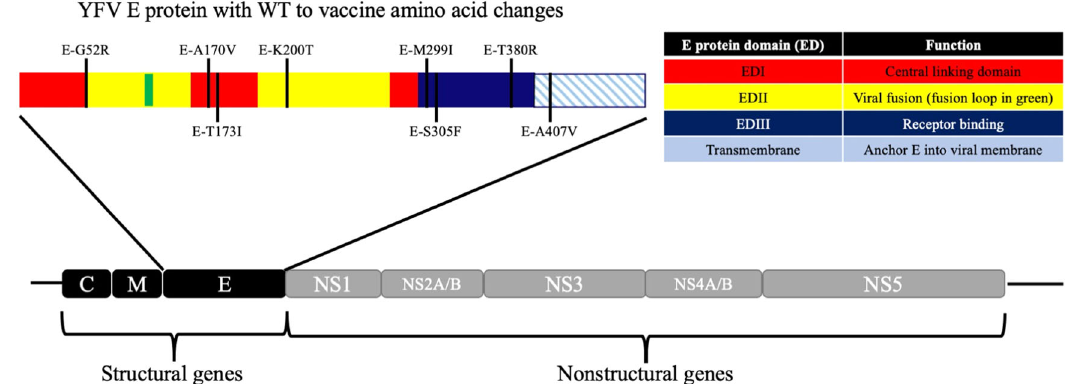
Fig. 1 Structure of the YFV genome and E protein. The YFV genome is co-translationally cleaved by host and viral proteases. The E protein is displayed with amino acids that differentiate the WT YFV strain Asibi from the YFV vaccine strain 17D